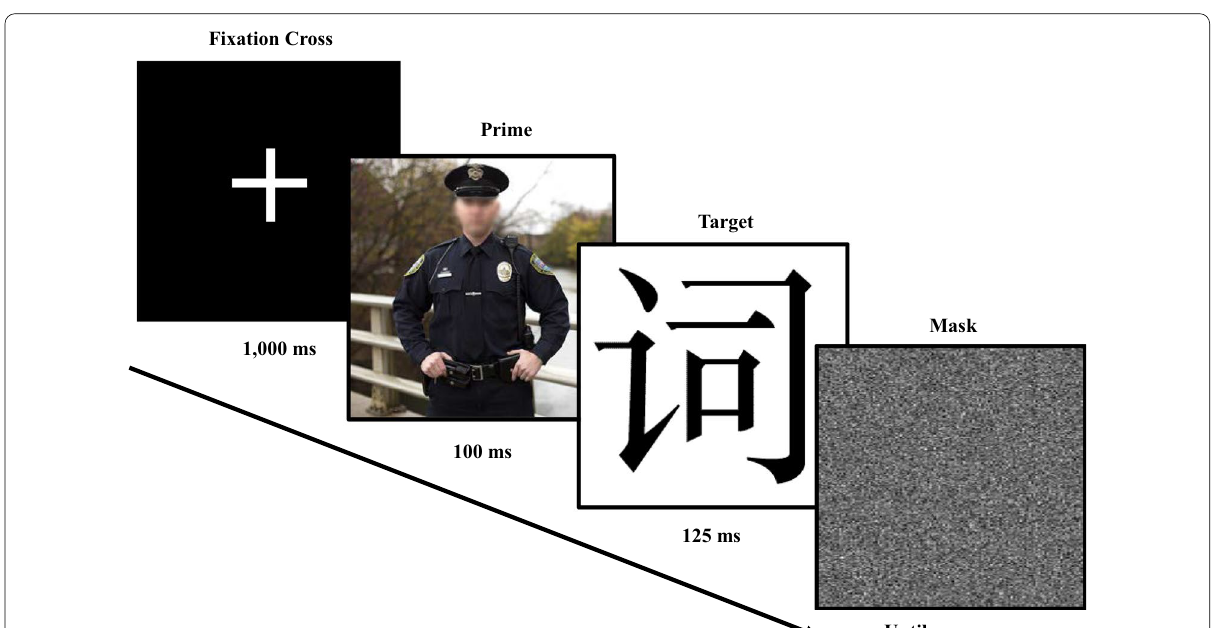
Fig. 1 Depiction of a single misattribution procedure